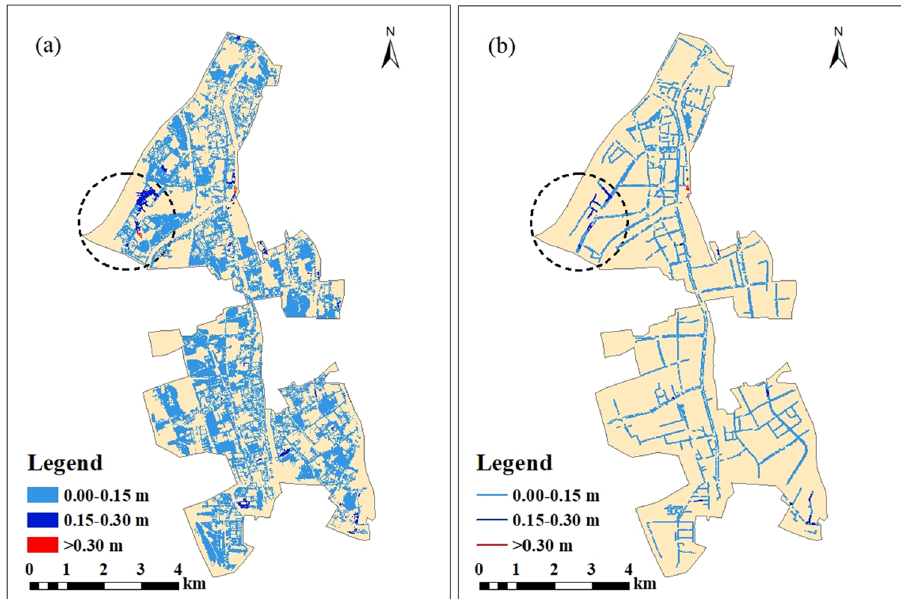
Figure 15. Distribution of ( a ) inundated areas and ( b ) pipelines where the differences in water depth between 2 and 100a rainfalls are greater than 0.15 m. This map was generated with ArcMap Version 10.0. (https:// www. esri. com/ en- us/ arcgis/ produ cts/ arcgis- deskt op/ overv iew).